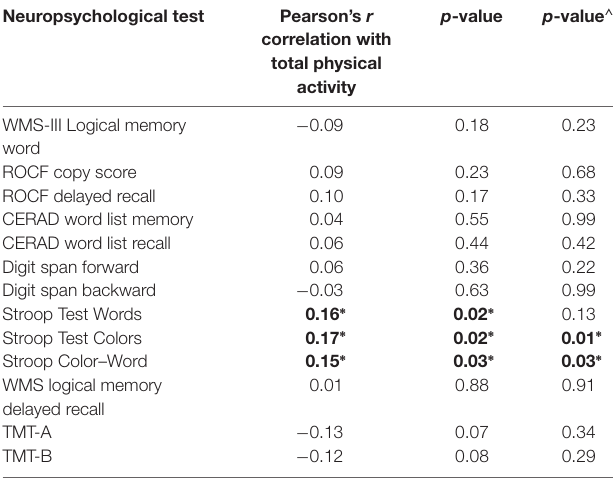
TABLE 2 | Neuropsychological test results and their correlation with the total amount of physical activity in METs. Neuropsychological test Pearson’s r correlation with